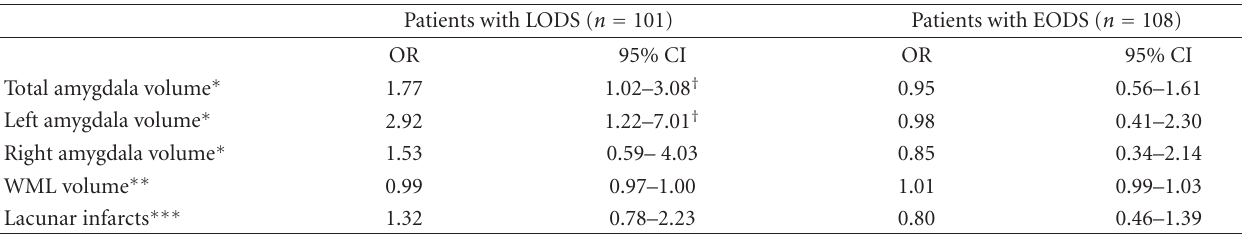
Table 3: The risk of LODS and EODS per decrease in amygdala volume, white matter lesion (WML), volume and lacunar